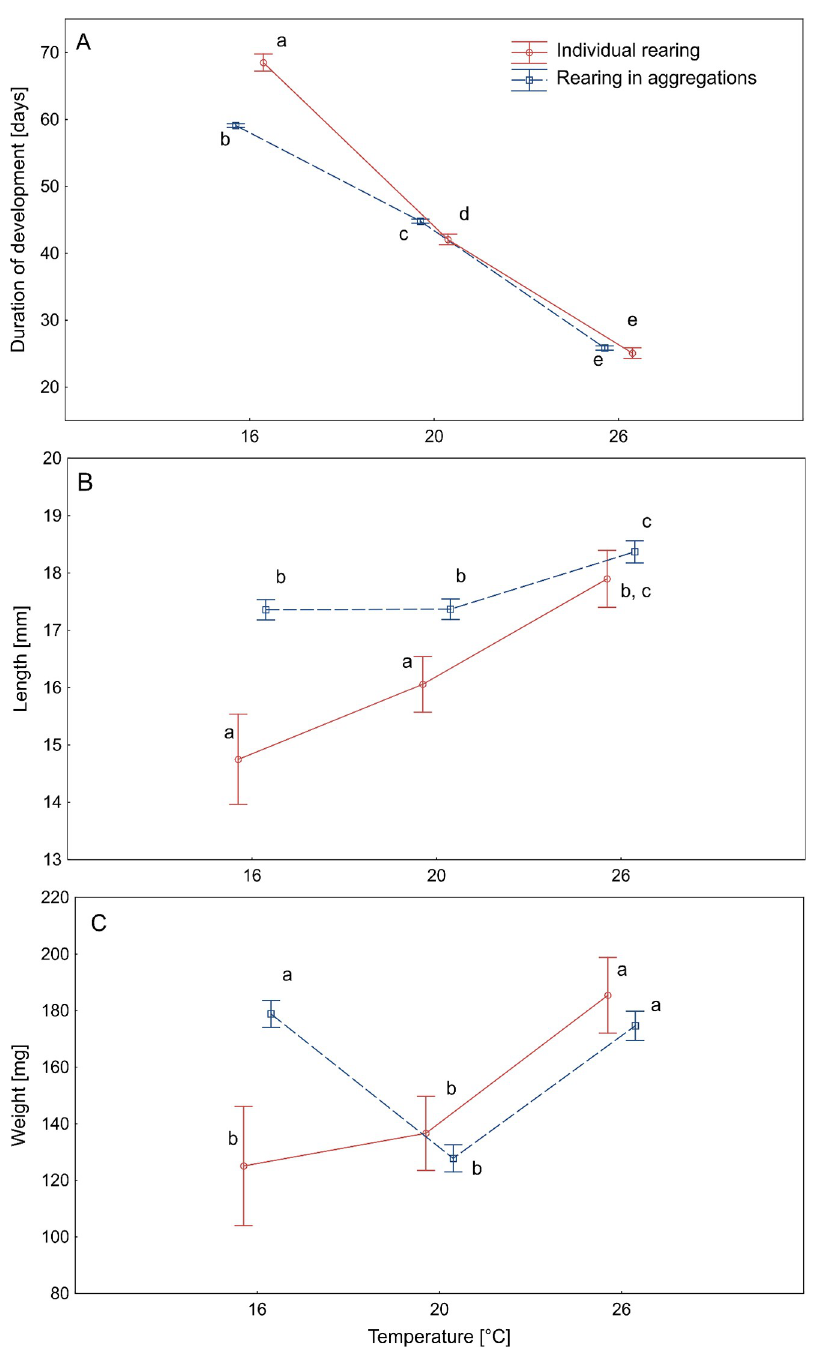
Fig 2. Mean duration of development (A), length (B) and weight (C) of adult Necrodes littoralis reared individually and in aggregations. Duration of development is time in days from the oviposition to the emergence of an adult beetle. Whiskers represent the 0.95 confidence intervals. Different letters denote significant differences in pairwise comparisons at p = 0.05 using Tukey’s HSD test. We used all emerged individuals for the calculations. The total sample size at 16˚C, 20˚C and 26˚C was respectively: 198, 192 and 167 in the protocol with aggregations and 10, 26 and 25 in the protocol with individual rearing.